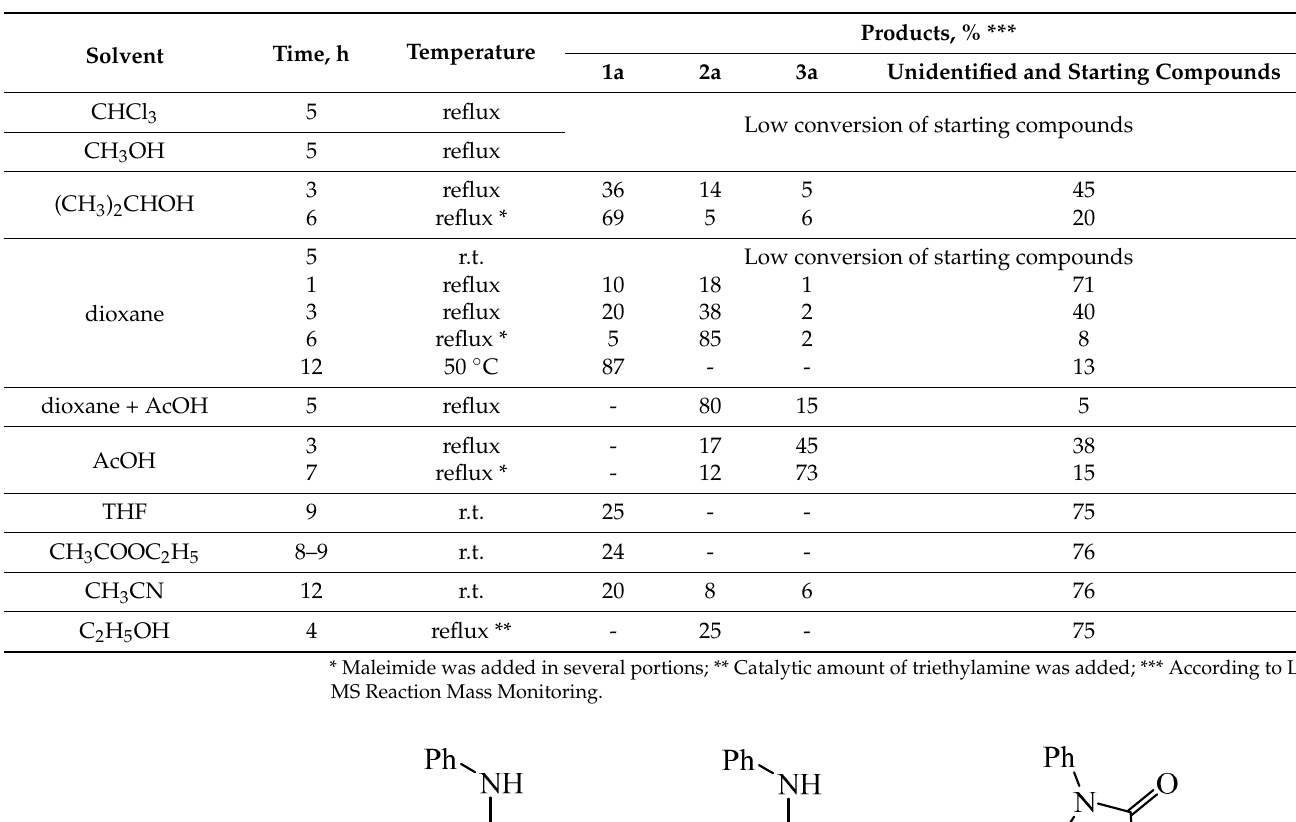
Table 1. Conditions for the reaction of N-arylmaleimides with thioacetamide and the product composition.